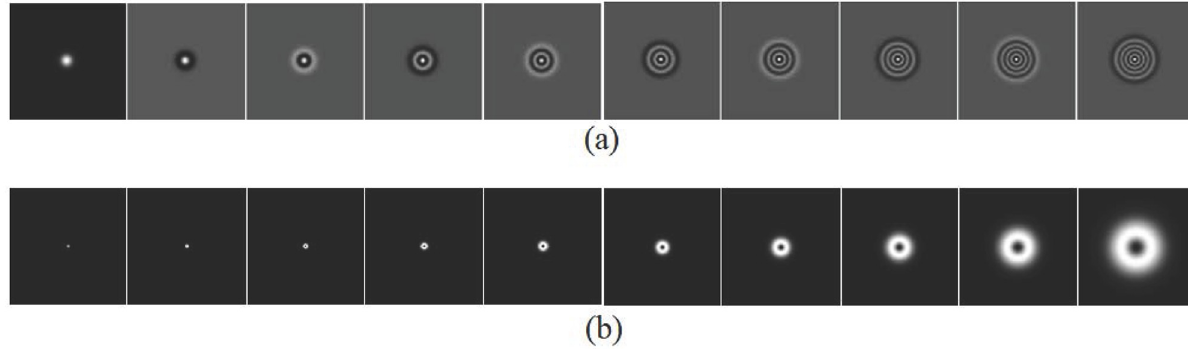
= 11 pixels (left: p = 0, right: u